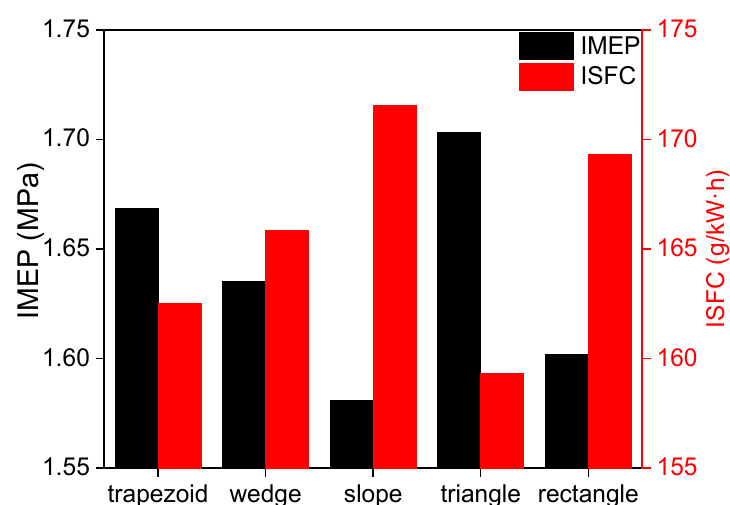
Figure 6. The e ff ects of di ff erent injection rate shapes on indicated mean e ff ective pressure (IMEP) and indicated specific fuel consumption Figure 6. The effects of different injection rate shapes on indicated mean effective pressure (IMEP) and indicated specific fuel consumption (ISFC).